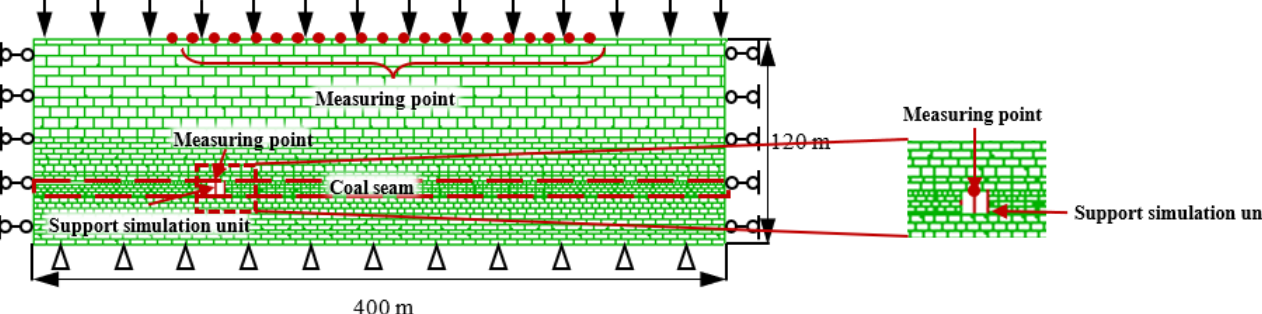
Figure 2. Mechanical model of numerical calculation. Table 1. Physical and mechanical parameters of coal and rock strata.